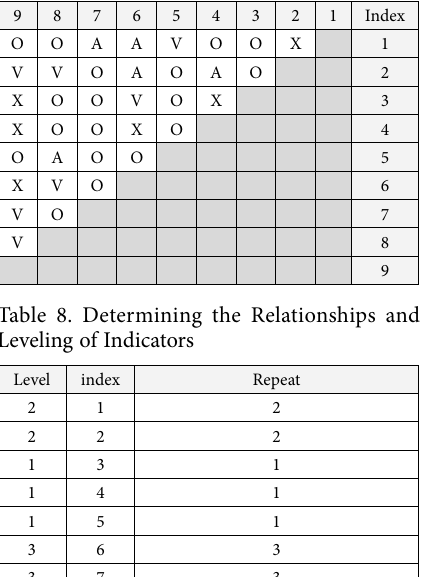
Table 5. Structural self-interactive matrix Table 6. Initial reachability matrix